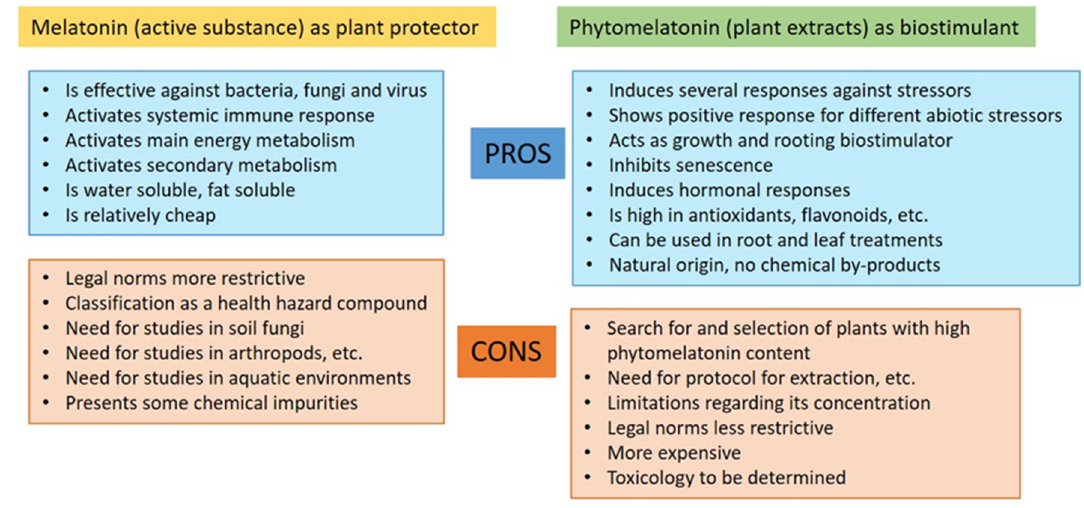
Figure 2. Pros and cons of the possible use of chemical melatonin and rich-phytomelatonin extracts according to EC legislation.